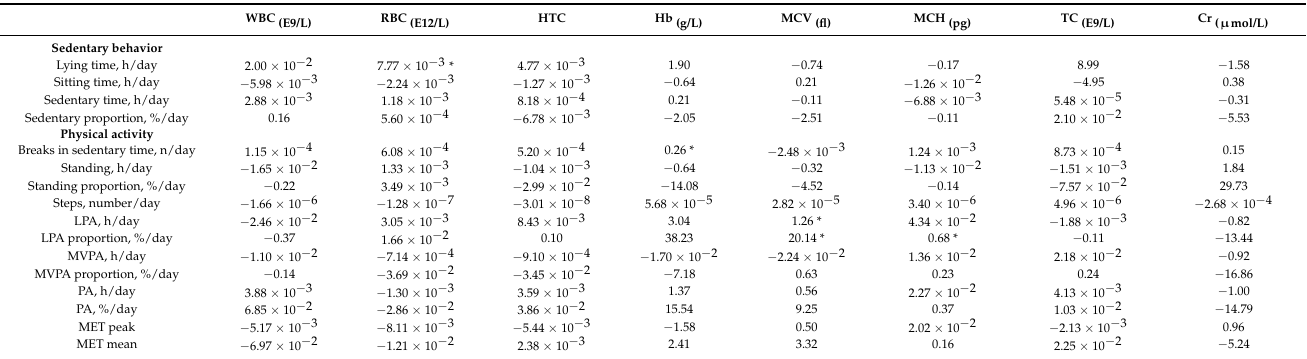
Table 5. Age-, sex- and BMI-adjusted linear mixed regression estimates (B values) between sedentary behavior, physical activity and common blood count parameters and Cr (model